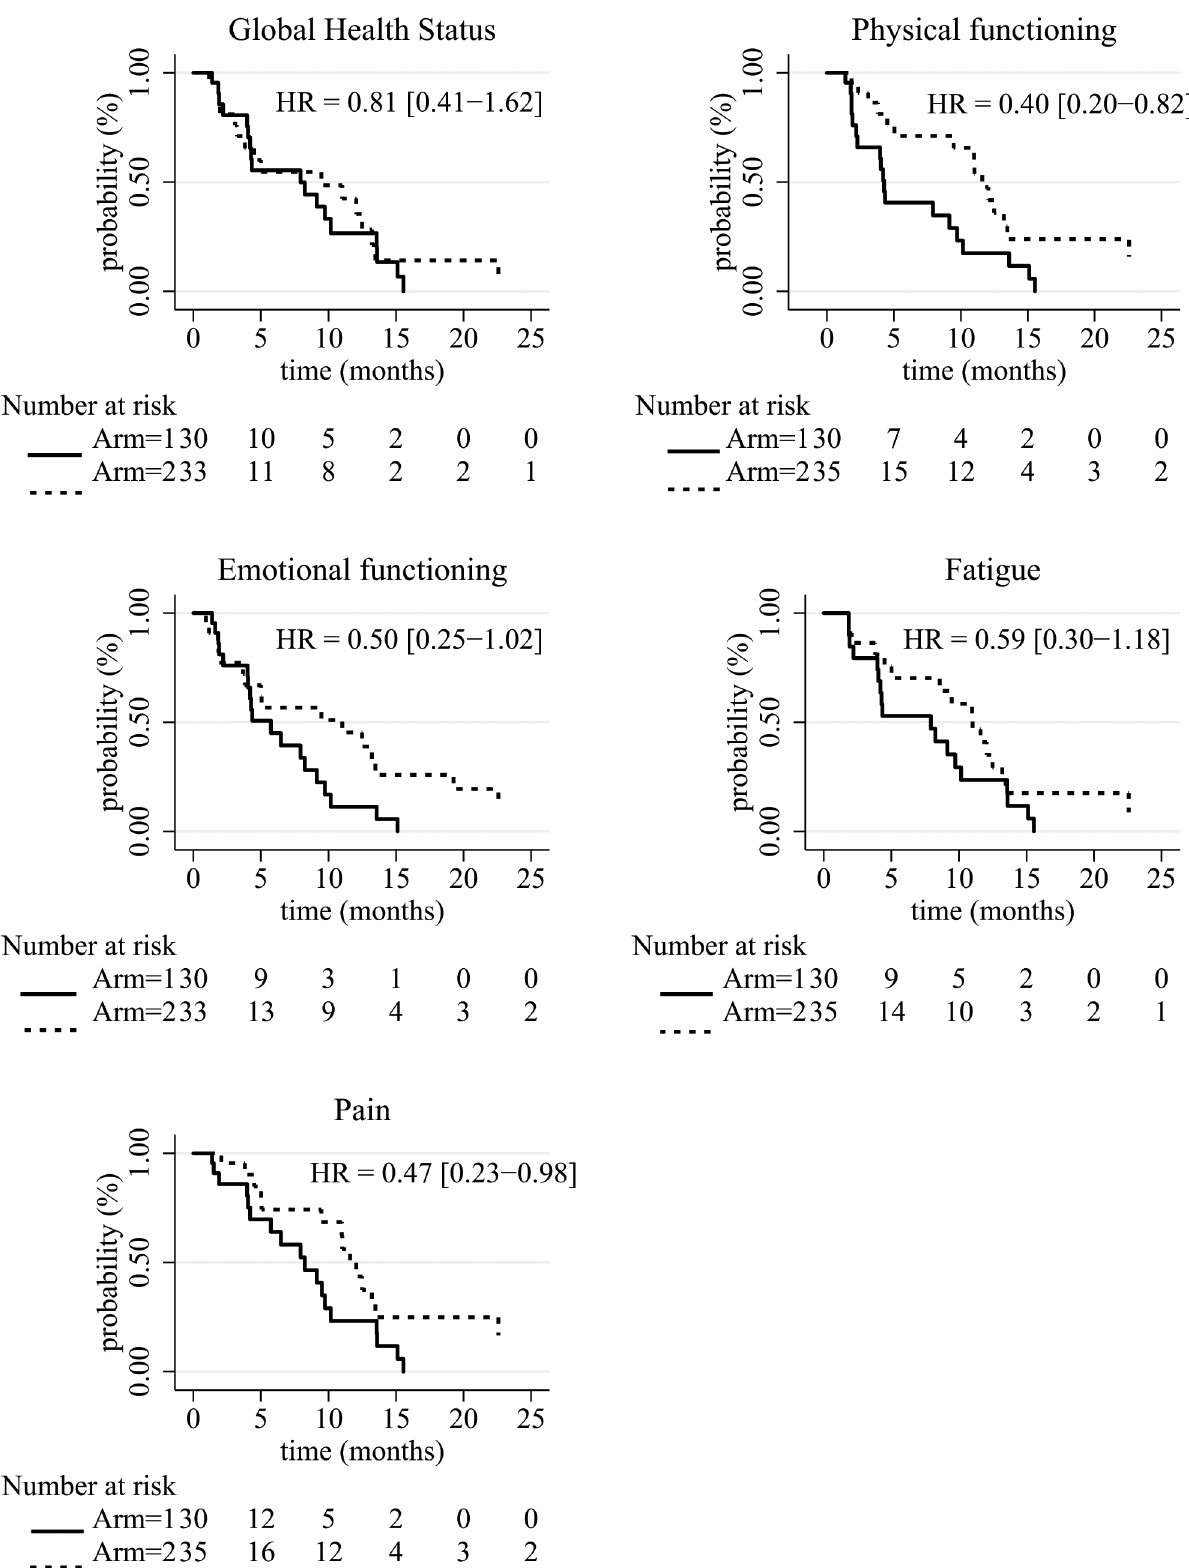
Fig 2. Kaplan-Meier survival curves of the HRQoL deterioration-free survival by treatment arm for the raw and the weighted analysis. Arm 1: gemcitabine alone, Arm 2: gemcitabine + FOLFIRI.3. doi:10.1371/journal.pone.0125350.g002 PLOS ONE | DOI:10.1371/journal.pone.0125350 May 26,